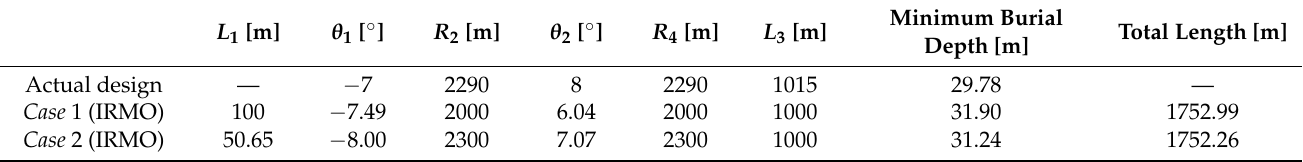
Table 8. Comparison of parameter design